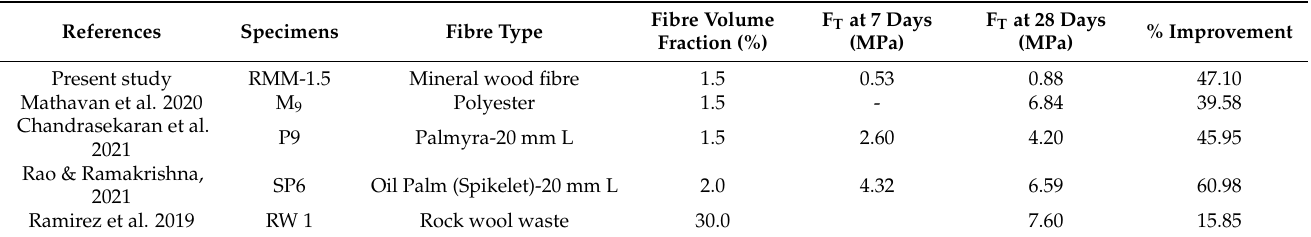
Table 6. Comparison of present with previous studies in terms of optimal flexural strength values and improvement attained